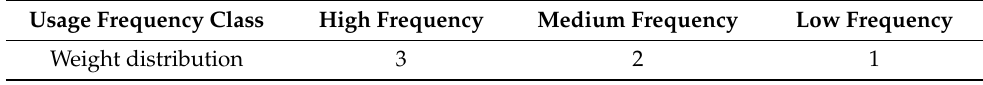
Table 1. Frequency of assigning weights.